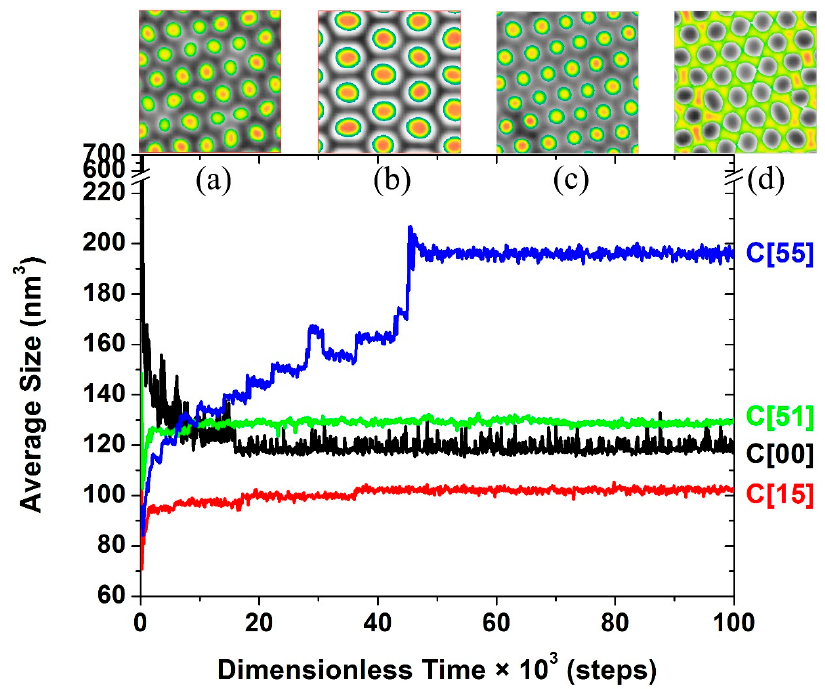
Figure 2. Change in average size for the same 3C4 system under C[00], C[55], C[15], and C[51] interaction conditions are shown in black, blue, red, and green lines, respectively, whose density slices at the final equilibrium state along the X–Y plane are shown in subfigures ( a )–( d ), respectively.